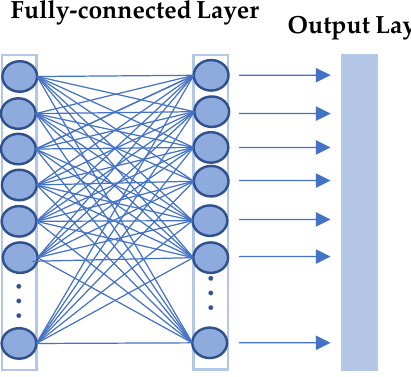
Figure 5. Structure of the fully connected layer.